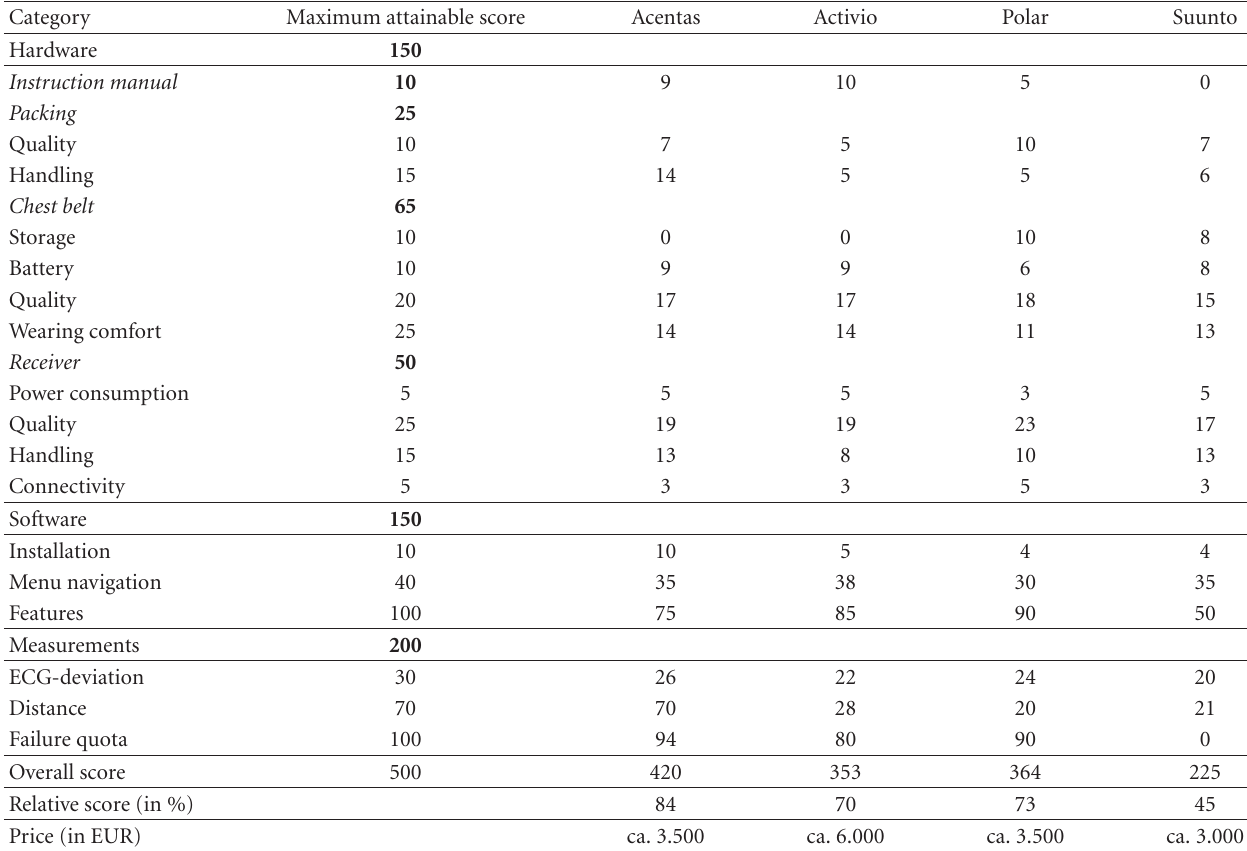
Table 5: Summary of all